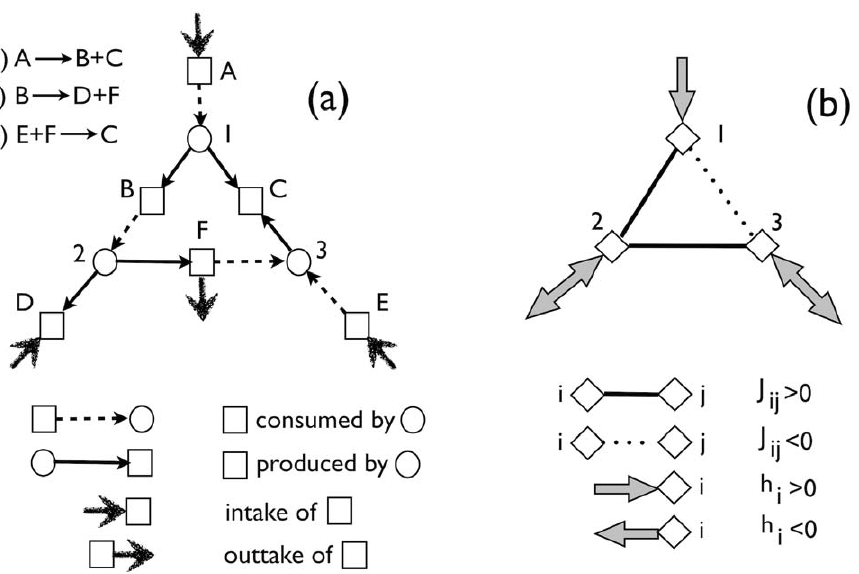
Figure 1. Mapping of a reaction network to a system of interacting reactions. Panel ( a ) Toy reaction network with reactions represented as circles and chemical species as squares. Continuous, dashed, incoming drawn and outgoing drawn arrows denote stoichiometric coefficients and w 0 , j m v 0 , u m v 0 and u m w 0 . Panel ( b ) Reduced reaction network with couplings and ‘‘fields’’ given by (9). Continuous, uptakes, respectively j m i i dotted, incoming grey and outgoing grey arrows denote respectively J ij w 0 , J ij v 0 , h i w 0 and h i v 0 . For instance, J 13 ~{ j C u A = x A w 0 . Grey arrows are double-headed when the sign of h depends on the precise values of stoichiometric coefficients and uptake fluxes. h 1 ~ j A 1 u D = x D z j F u F = x F depends on the choice of the j ’s and u ’s, since the first term in the sum is negative while the For instance, the value of h 2 ~ j D 2 2 second is